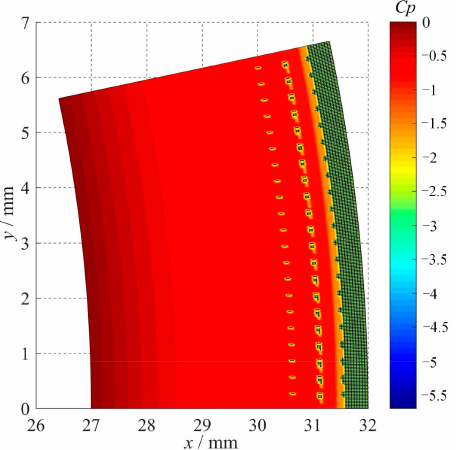
Figure 12. Pressure coefficient with encrypted texture